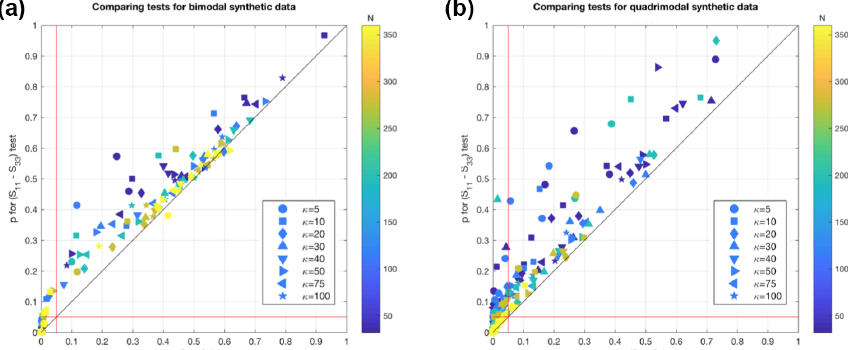
Figure 9. Eigenvalue ratio plots comparing the relative performance of the two tests proposed in this paper. The red lines denote p values for either test at p = 0 . 05, and the diagonal black line is the locus of points where p(S 1 − S 3 ) = p(S 11 − S 33 ) . (a) For bimodal synthetic datasets with size ( n ) varying from 32–360 and concentration ( κ ) varying from 5–100, both tests perform well and reject the majority of the datasets ( p (cid:29) 0.05). The p values for the S 11 –S 33 test are, on average, slightly higher than those for the S 1 – S 3 test across a range of dataset sizes and concentrations. (b) For quadrimodal synthetic datasets, many of the p values are <0.05, and this is especially true for the larger datasets (higher n , green–yellow). Smaller datasets (blue) can return p values